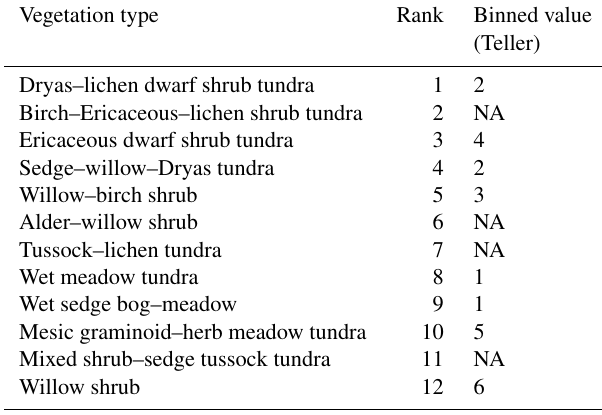
Table A1. Vegetation classes ranked by observed SWE from lowest SWE (1) to highest SWE (12) at Teller. All binned values are significantly different from each other.